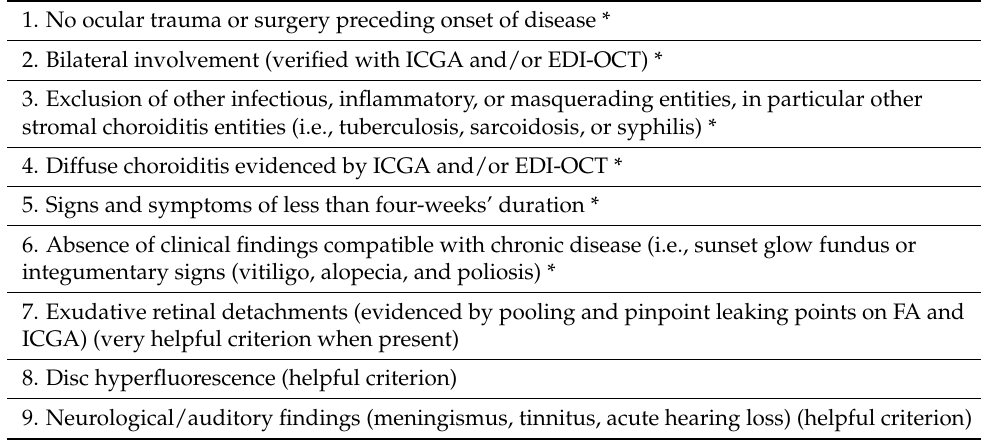
Table 6. Diagnostic criteria for initial onset VKH disease